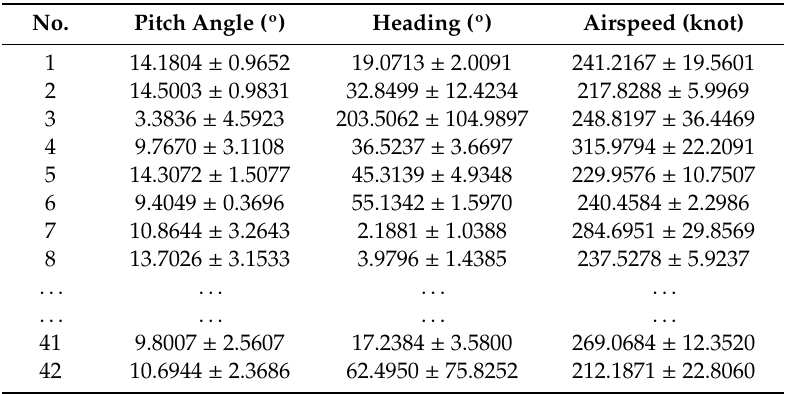
Table 3. Flight maneuvering data after encountering di ff erent failures.